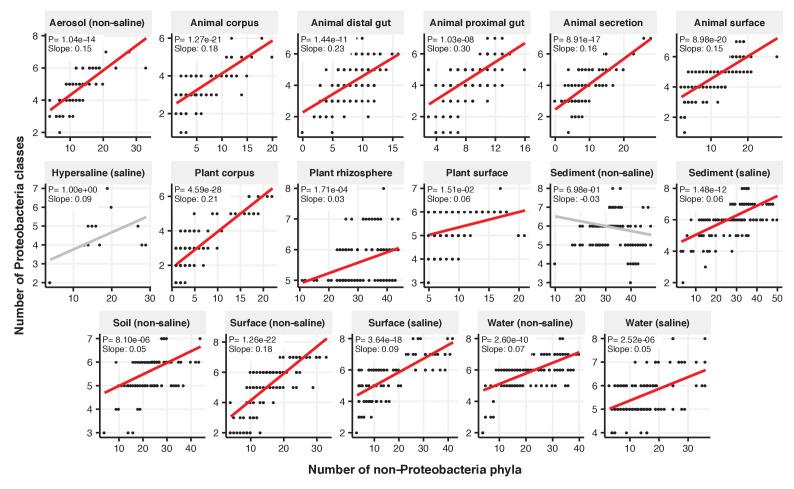
Focal-lineage diversity as a function of community diversity across biomes in Proteobacteria.Linear models are shown for the number of classes per phylum (y-axis) as a function of community diversity (number of non-focal phyla, x-axis) in each of the 17 environments (EMPO3 biomes). Only environments containing the focal lineage are shown. P-values are Bonferroni corrected for 17 tests. Significant (p<0.05) models are shown with red trend lines.